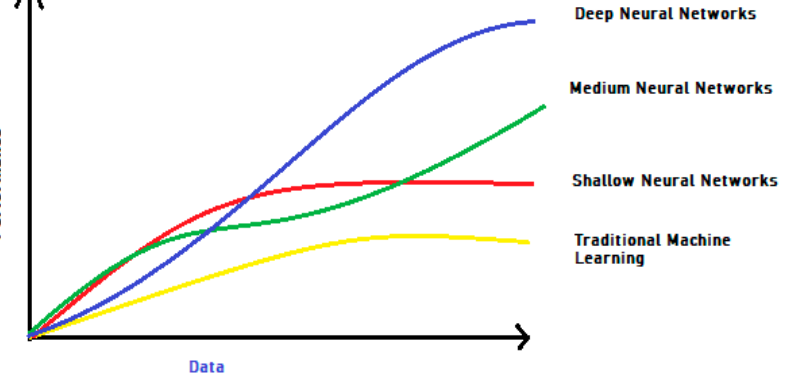
Figure 1. Traditional ML vs. DL algorithms performance assessment (Caroppo, Leone, and Siciliano, 2020).